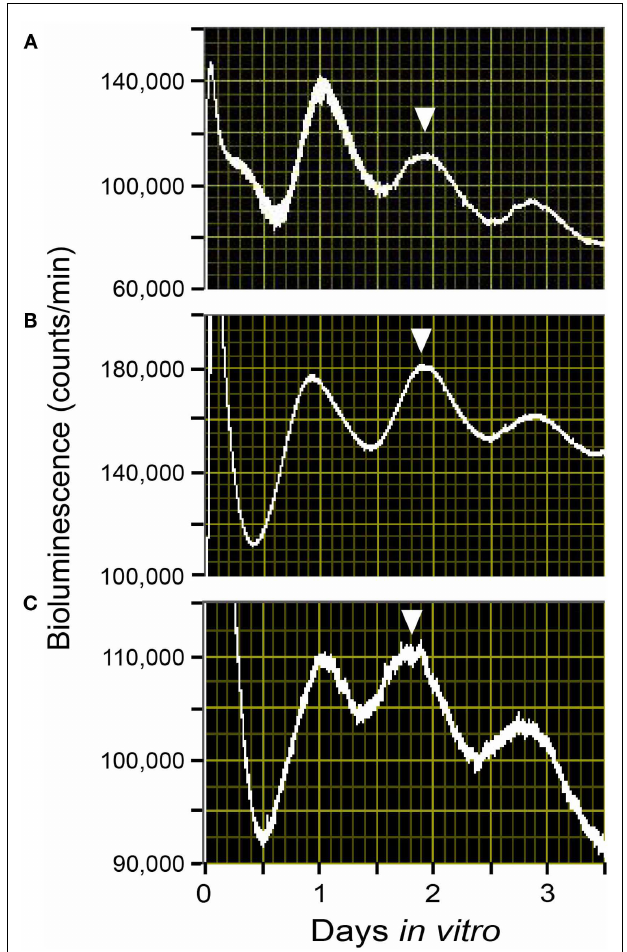
FIGURE 1 | Rhythms of Per1::Luc light emission by uterus explants from Per1::Luc rats in a light-dark cycle (LD) . Shown are raw data from uterus tissues from ad lib-fed Per1::Luc female rats in non-pregnancy (A) , embryonic day 12 (B) , and embryonic day 22 (C) in a 12:12h LD cycle.The phase of the tissue in vivo has been considered to be best reflected by the phase of the peak in vitro during the first full subjective day (1–2.5days after explant) as previously described (9, 49).The phase of these peaks is consistent from animal to animal. Here, the phase statistically chosen is indicated by the inverted